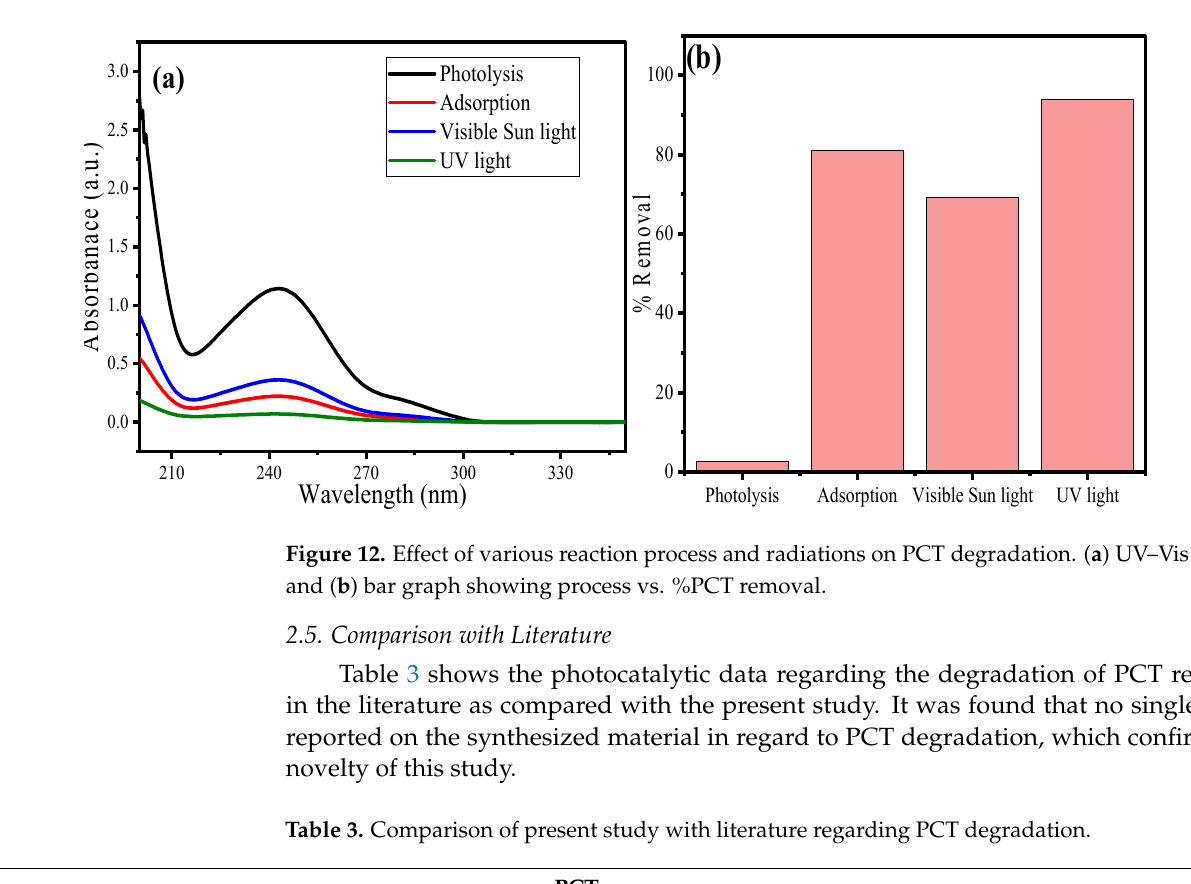
Figure 11. Photodegradation of paracetamol by NiWO 4 /CoWO 4 NC in the presence of different scav- engers.